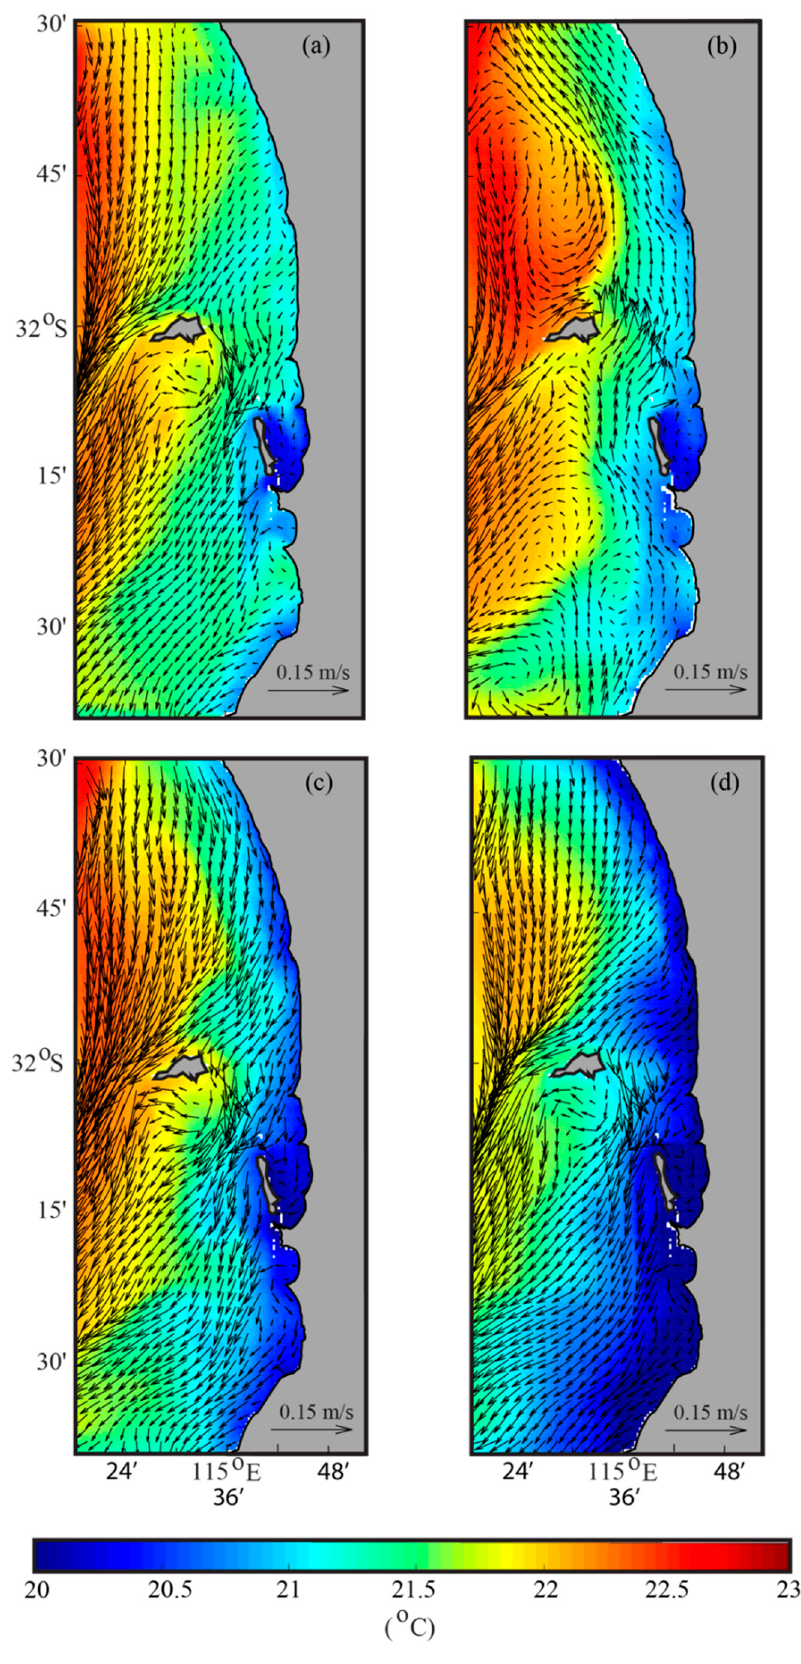
Figure 7. Estimated near-bottom velocity and near-bottom temperature 3-day means averaged over four different wind events: ( a ) May 13–15, ( b ) May 16–18, ( c ) May 19–21, and ( d ) May 22–24.